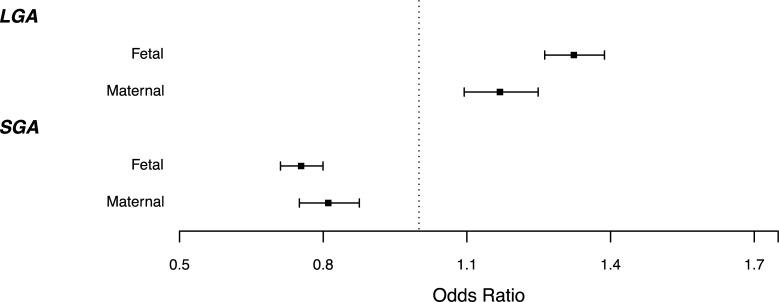
Odds of SGA or LGA per 1 decile higher fetal (N = 11,951; ALSPAC, EFSOCH, NFBC1966, NFBC1986) or maternal (N = 5,181; ALSPAC, EFSOCH) GS for birth weight.Error bars represent 95% confidence intervals, and weights used for fetal and maternal GS are independent of maternal and fetal effect respectively.